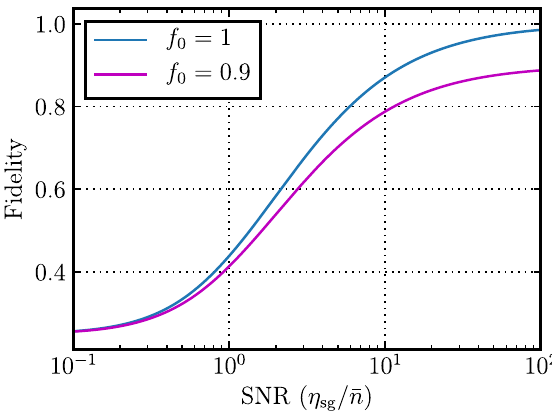
Fig. 9 Fidelity of satellite-to-ground entanglement transmission as a function of the signal-to-noise ratio (SNR) of the transmission medium. The source state is in eq. (31), and the fi delity after transmission is given by eq.